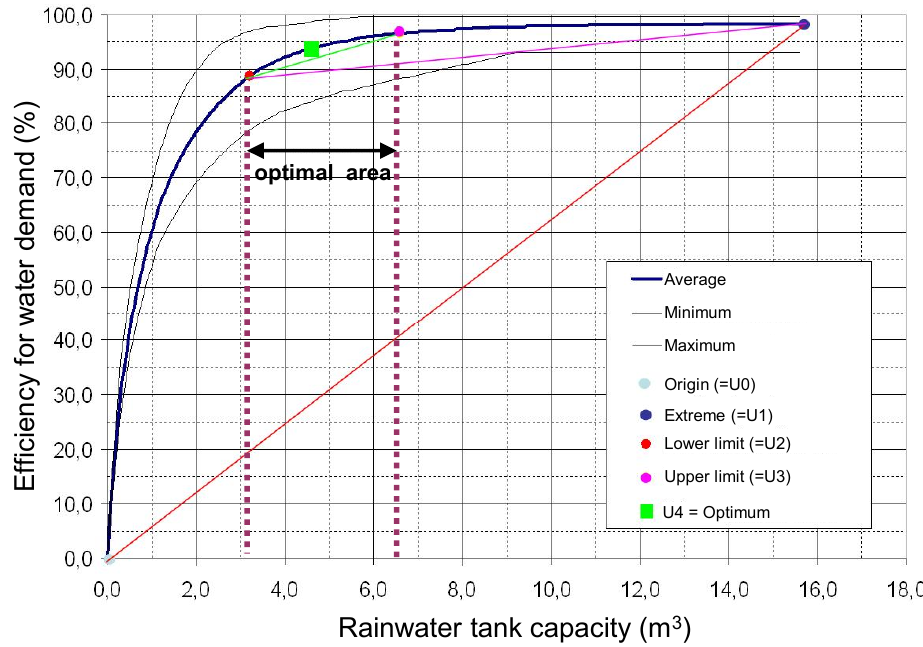
Figure 2. Automatic method of extraction of optimal area. Source [27] (Example for an individual